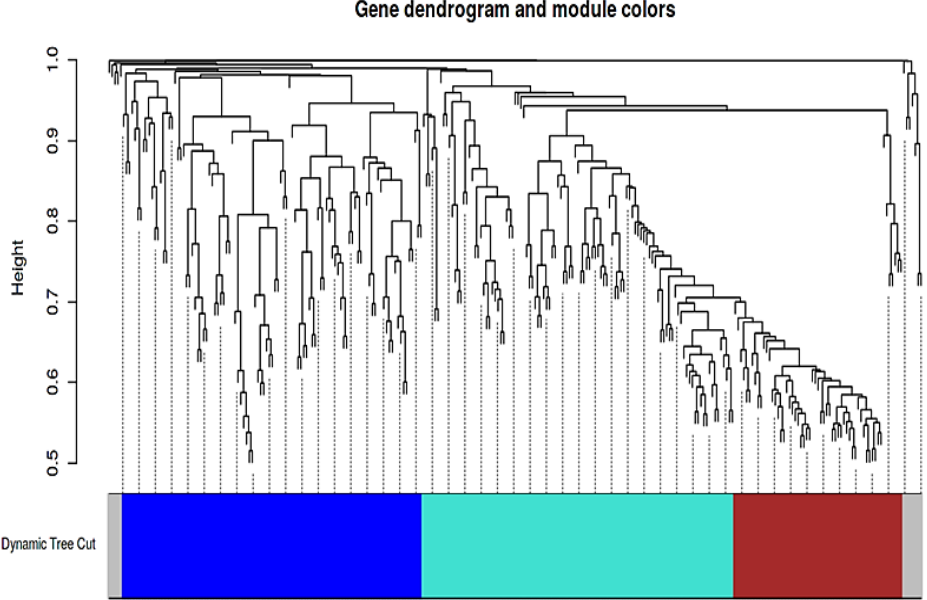
Figure 4. Cluster dendrogram and module assignment for modules from WGCNA. Branches of the dendrogram group contain densely interconnected, highly co-expressed genes and